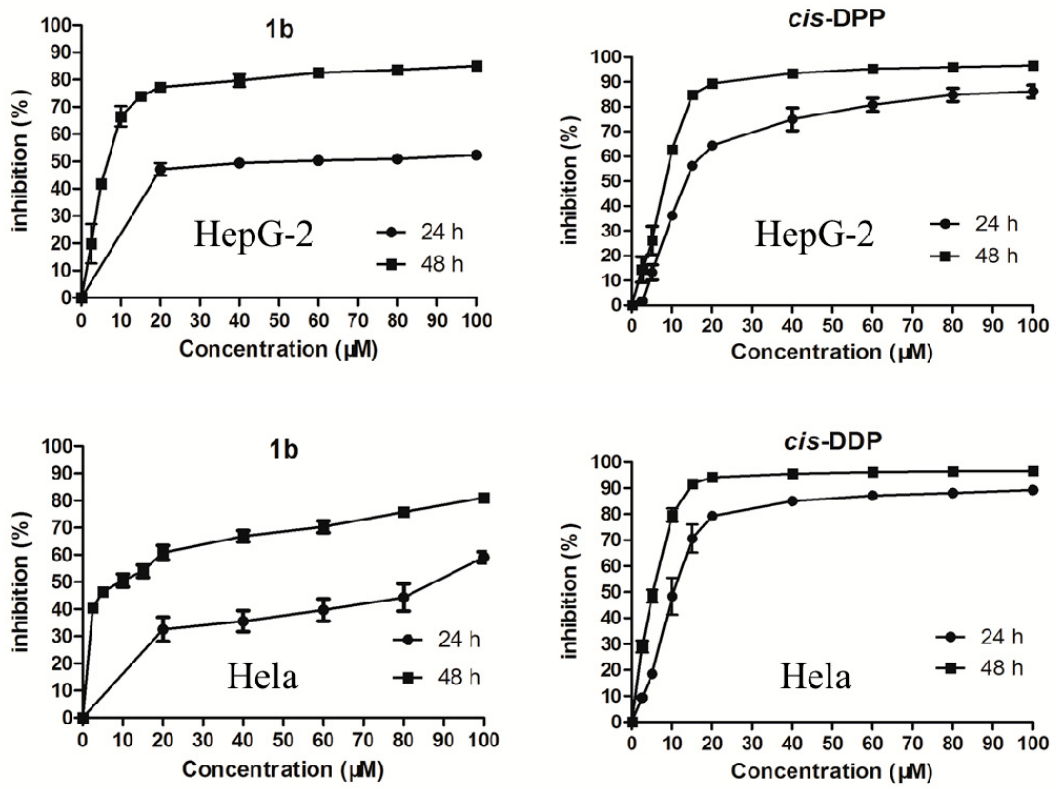
Figure 1. Inhibitory effects of compound 1b and cis -DDP on HepG-2 cells and Hela cells after 24 h and 48 h.